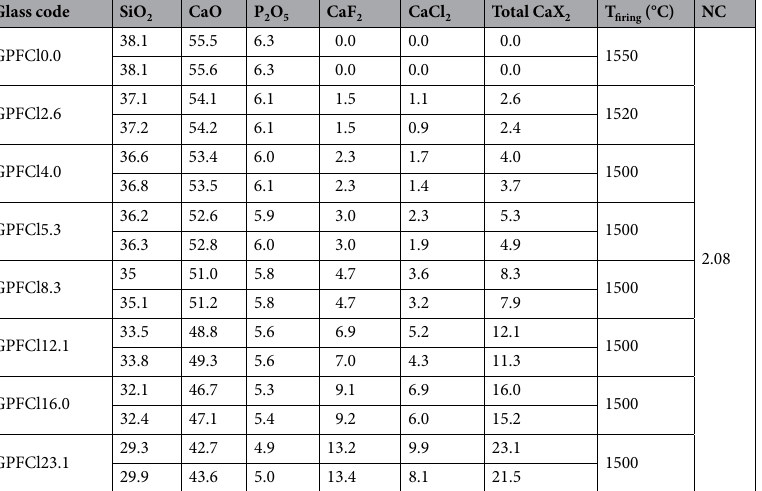
Table 1. Compositions of the Experimental Glasses in Mol%. For each glass, the first row is the nominal composition as-designed and the second row is composition re-calculated based on the chloride component analysis and assumed chlorine losses as CaCl 2